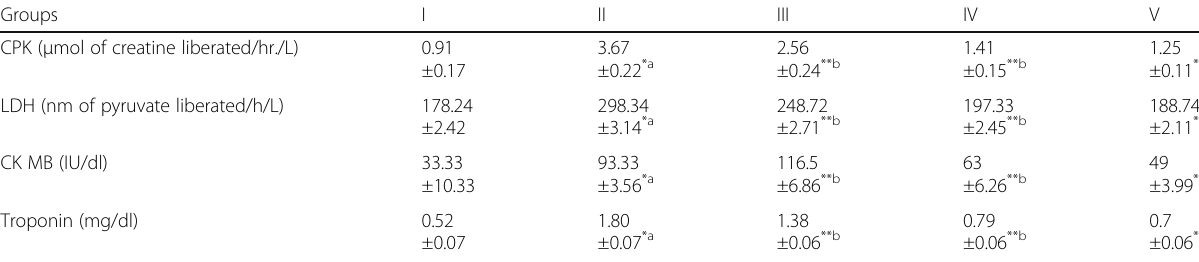
Table 1 Effect of aqueous extract of Caesalpinia bonducella L. (AECB) on activities of marker enzymes in serum of experimental animals